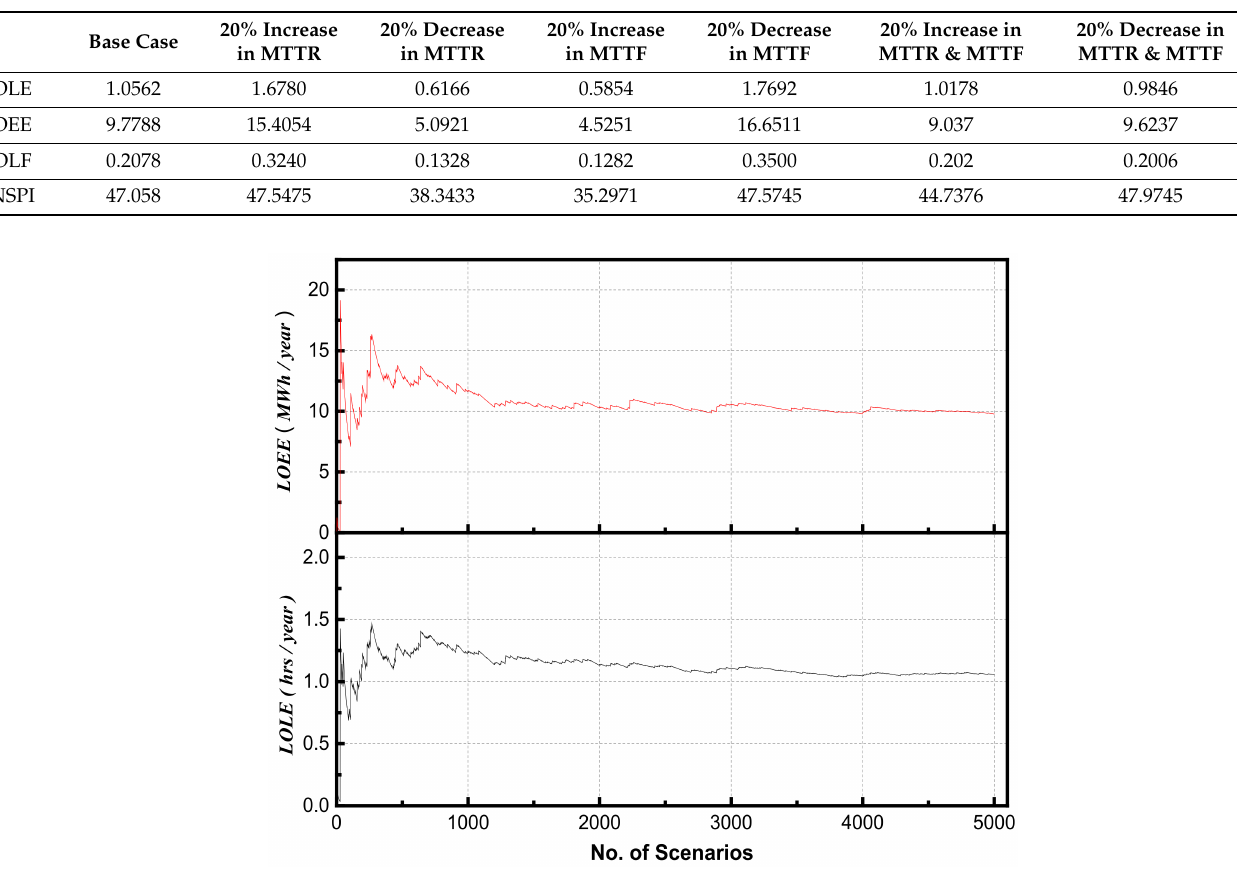
Figure 6. The convergence of reliability indices in the case of no